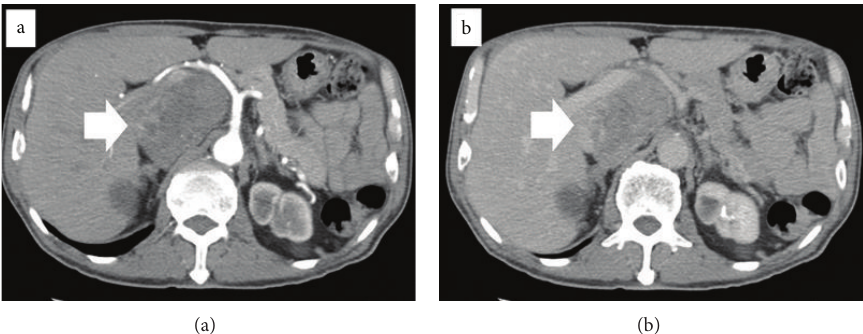
Figure 1: Enhanced computed tomography (CT) of the abdomen revealed a slightly enhanced heterogeneous tumor, 18mm in diameter, between the Spiegel lobe of the liver and the IVC in early-phase images ((a) arrow), with no enhancement and washout in late-phase images ((b) arrow).